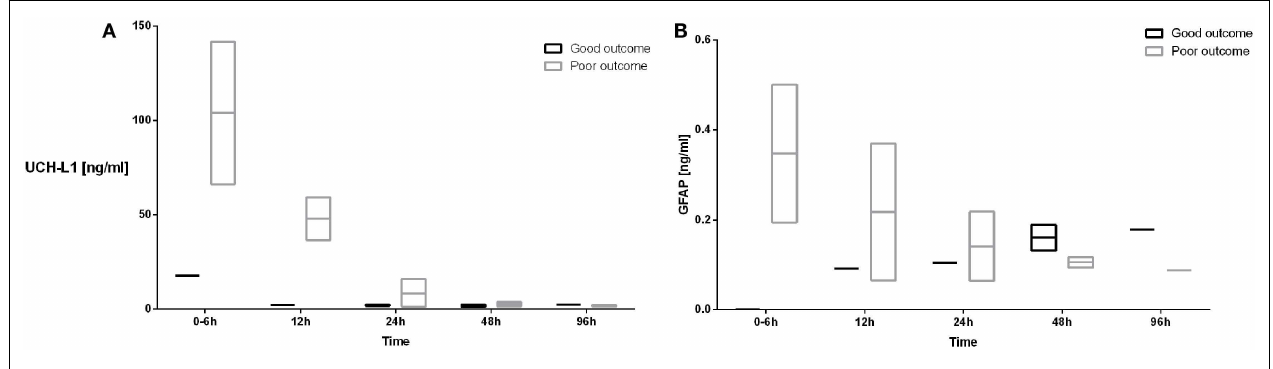
FIGURE 4 |The serum concentrations of UCH-L1 (A) and GFAP (B) in neonates with HIE who had good (black boxes and lines) and poor developmental outcomes (gray boxes and lines) are plotted over the